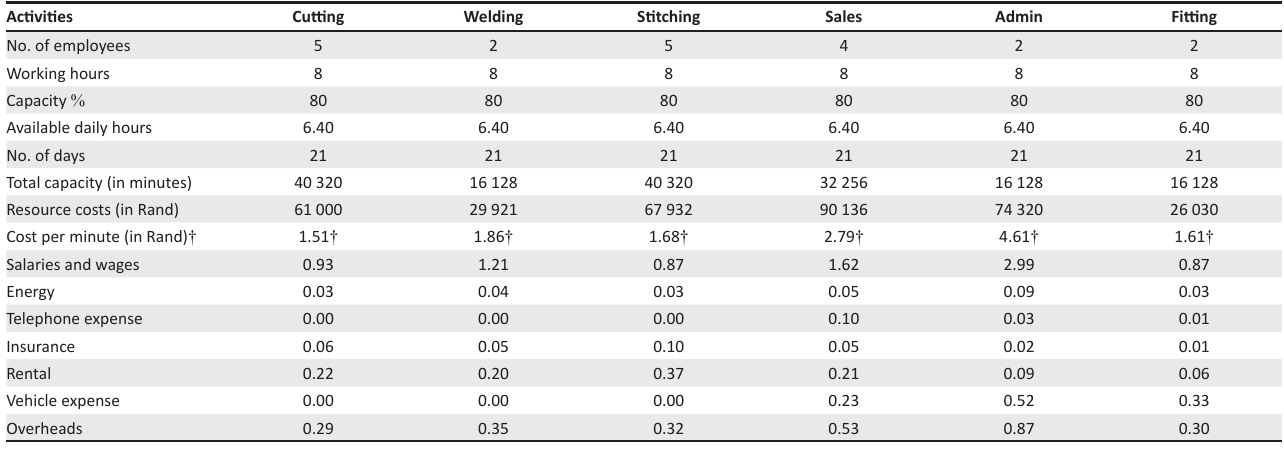
TABLE 4: Practical capacity and cost rates for each activity. Activities Cutting Welding Stitching Sales